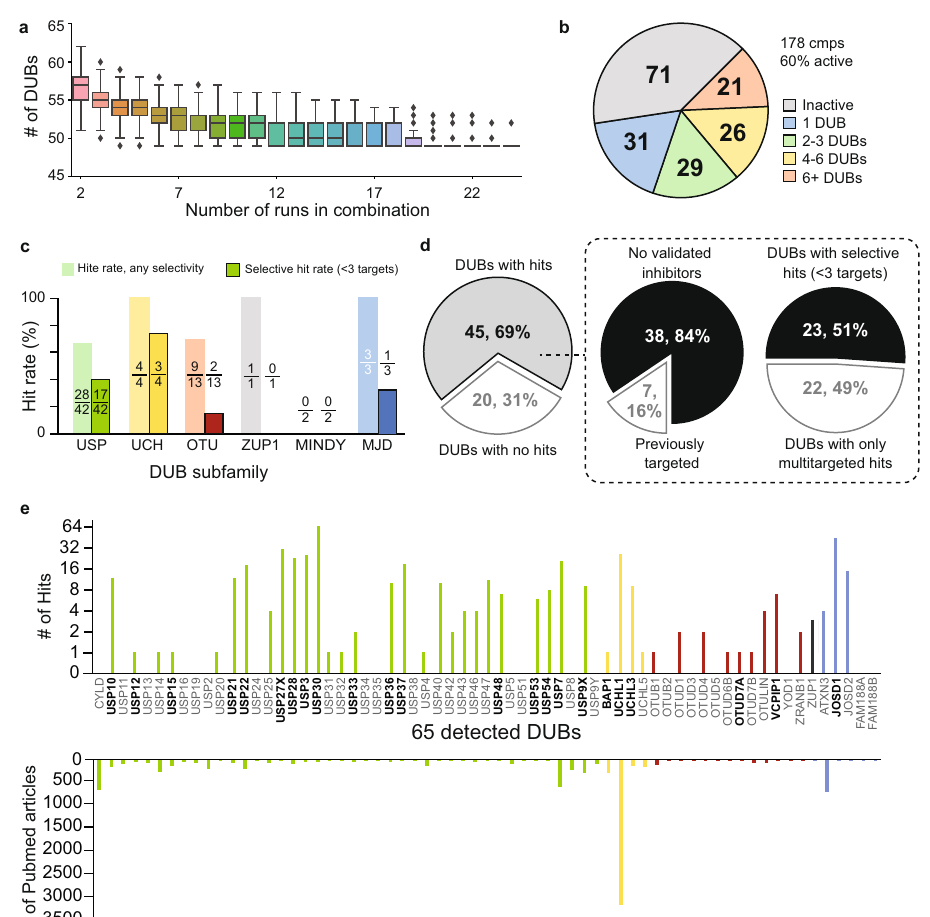
Fig. 2 | DUB trends in primary screening. a DUB ABPP assay performance The number of DUBs consistently detected across each unique combination of 2 – 24 assay runs ( n = 25 biologically independent experiments) quickly stabilized to 49, with 56 DUBs detected in >80% of runs. Line at center of box shows median number of DUBs detected for the given number of assays considered, box encapsulates the middle two quartiles, whilebarsrepresent bounds for the rest of the distribution. “ Outlier ” points as calculated by an inter-quartile method are shown as diamonds. b Most compounds were active and spanned diverse selec- tivitypro fi les. c Hitrateswereroughlyconsistentacrossthe DUBsubfamilies,with no hits identi fi ed for the MINDY subfamily. Insets above indicate number of DUBs targeted(numerator)withanyselectivity(lightcolor)orselectivelywith<3targets (dark color) out of all DUBs in the subfamily (denominator). d left: Hits were